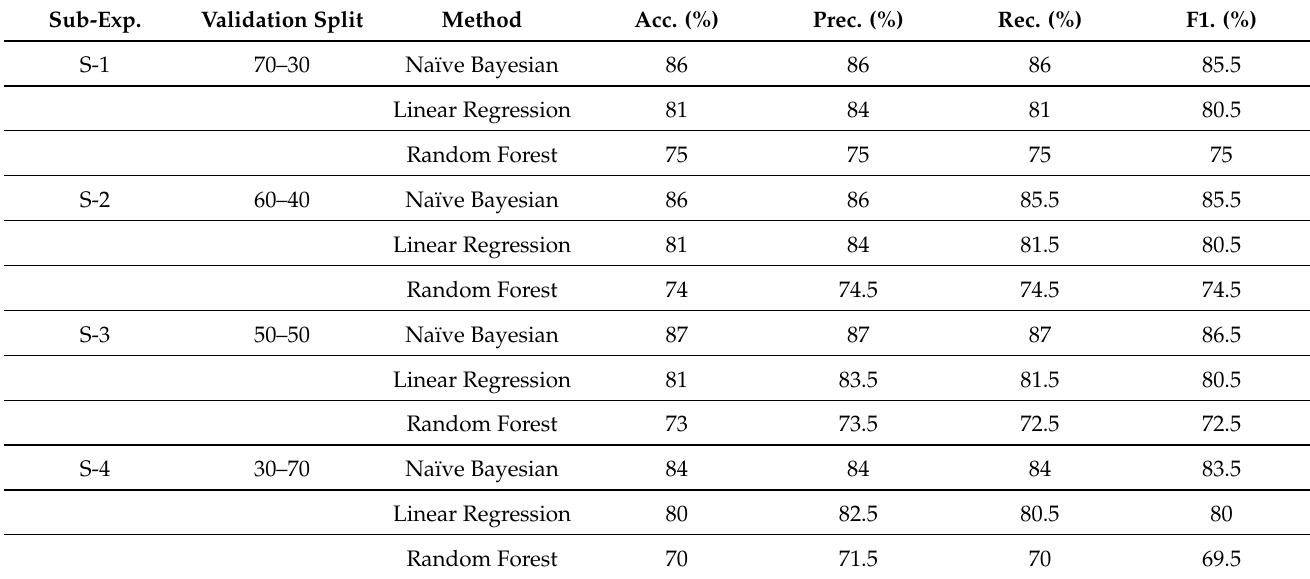
Table 3. Hold-out validation method results by applying TF-IDF features.